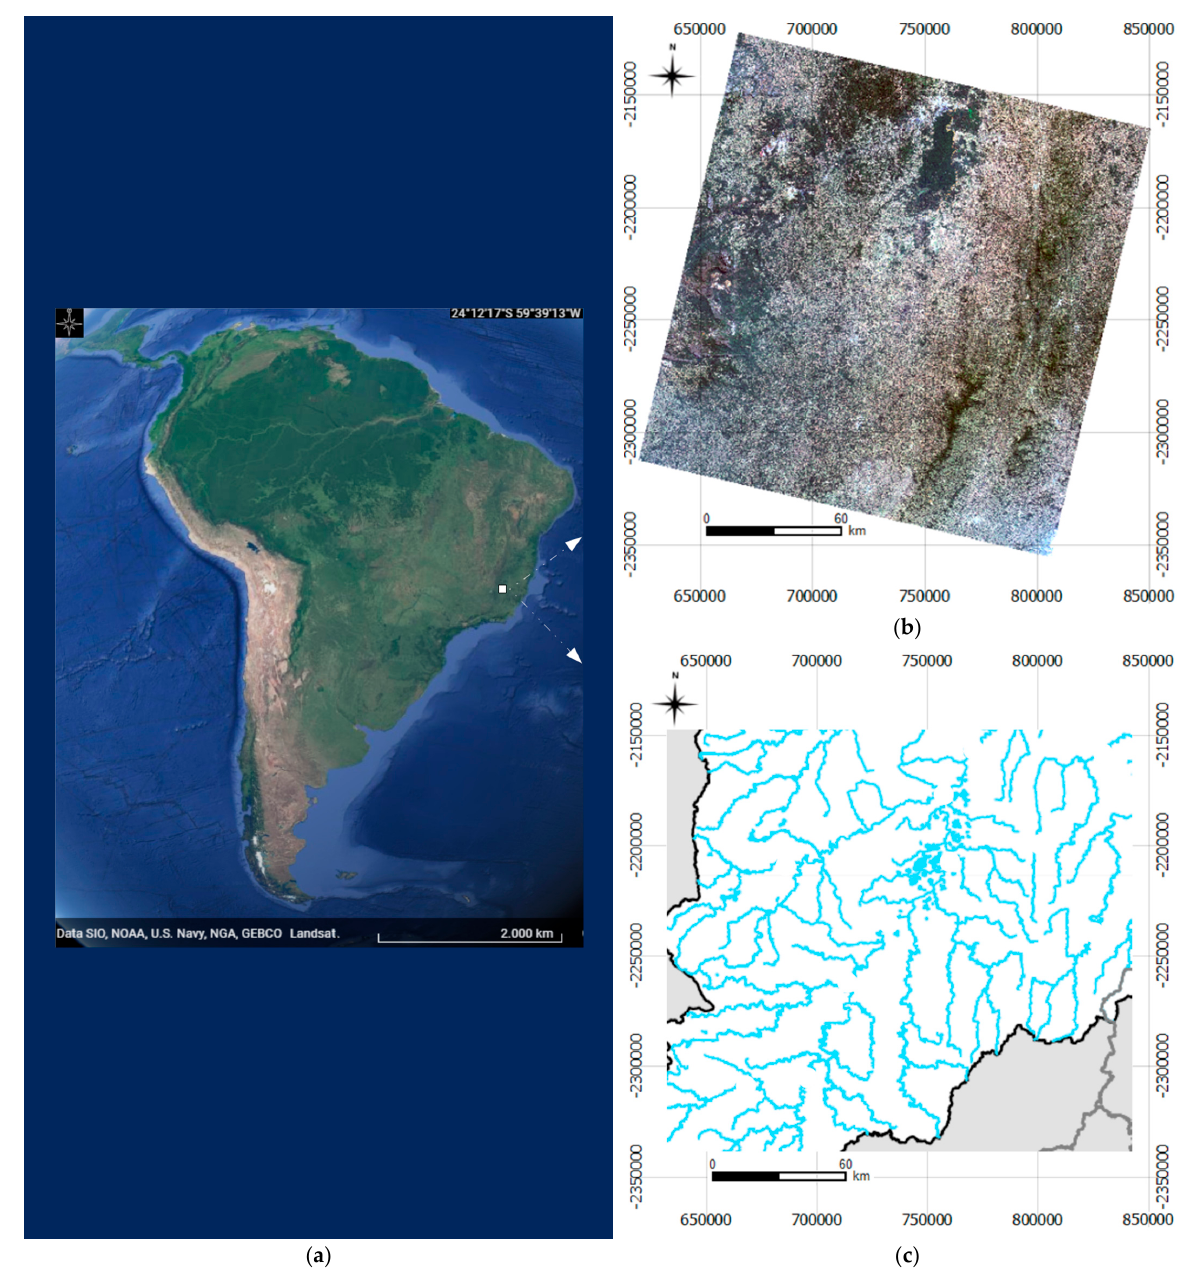
Figure 2. ( a ) South America, ( b ) the enhanced band composition (R(4)G(3)B(2)), and ( c ) the hydro- graphical map of part of the Doce River basin in Brazil. A band composition is an image composed of different bands of a satellite image.